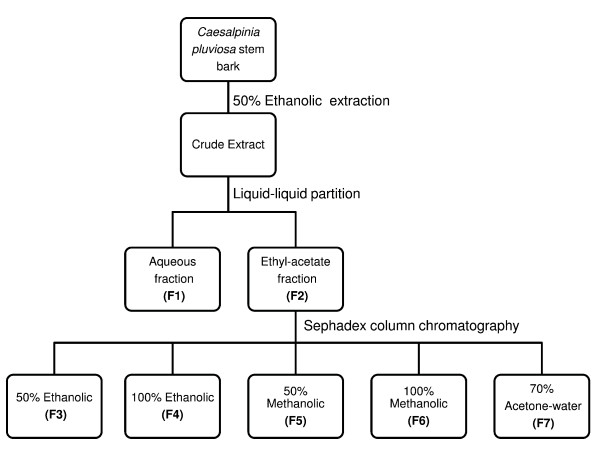
Schematic view of the extraction and fractionation of Caesalpinia pluviosa.